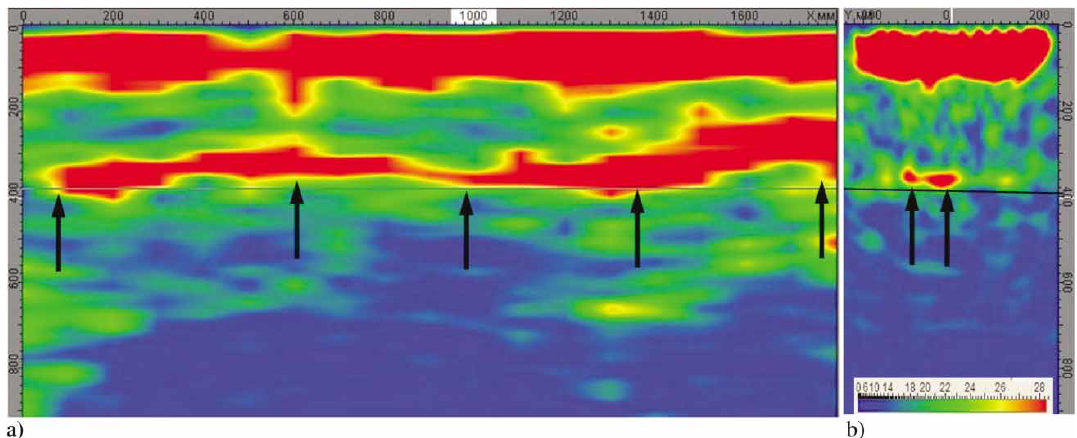
Fig. 10. Exemplary results obtained in measuring place no. 7: (a) image D; (b) image B